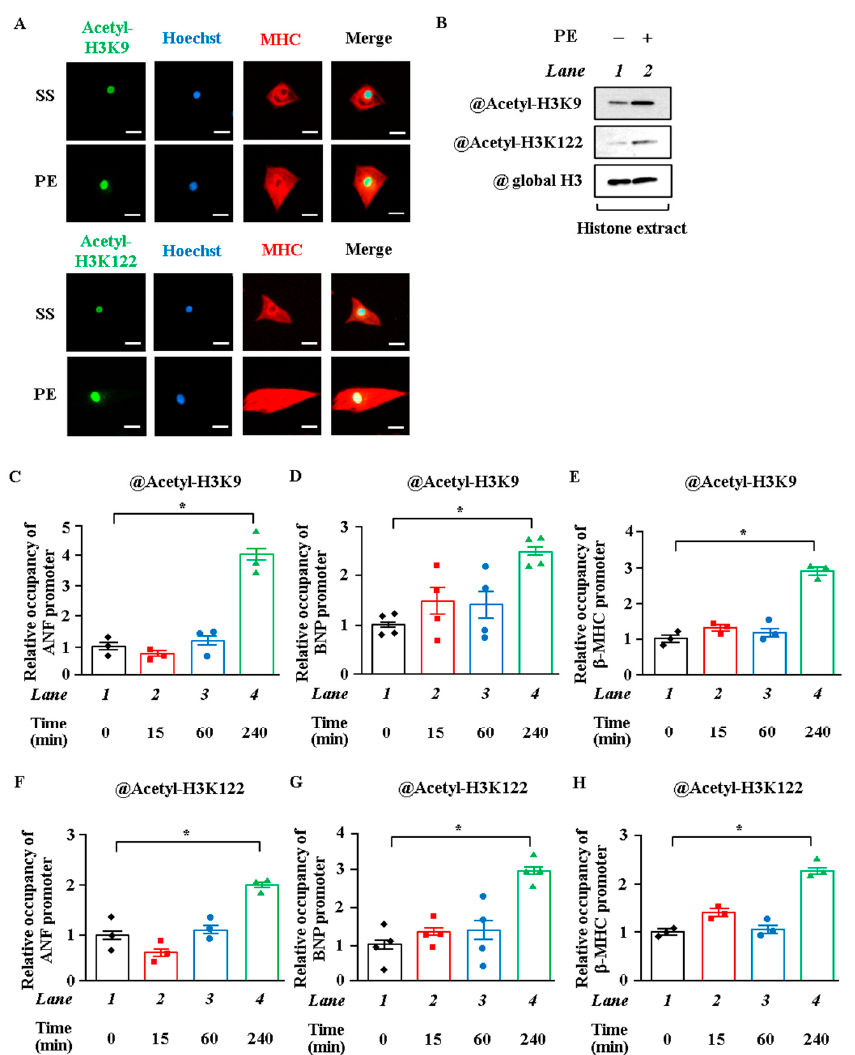
Figure 1. Phenylephrine stimulation induced histone acetylation in cardiomyocyte hypertrophy. ( A ) Primary cultured neonatal rat cardiomyocytes treated with or without phenylephrine (PE) (30 µ